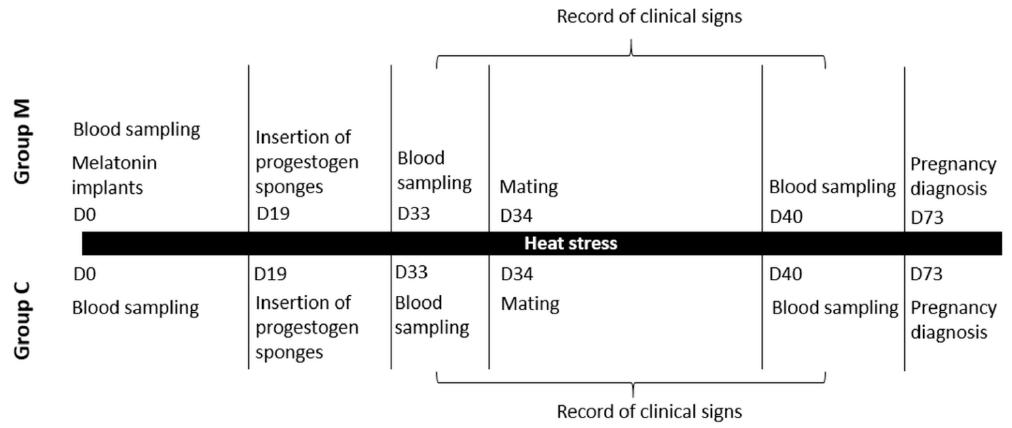
Figure 1. Experimental overview of the study.